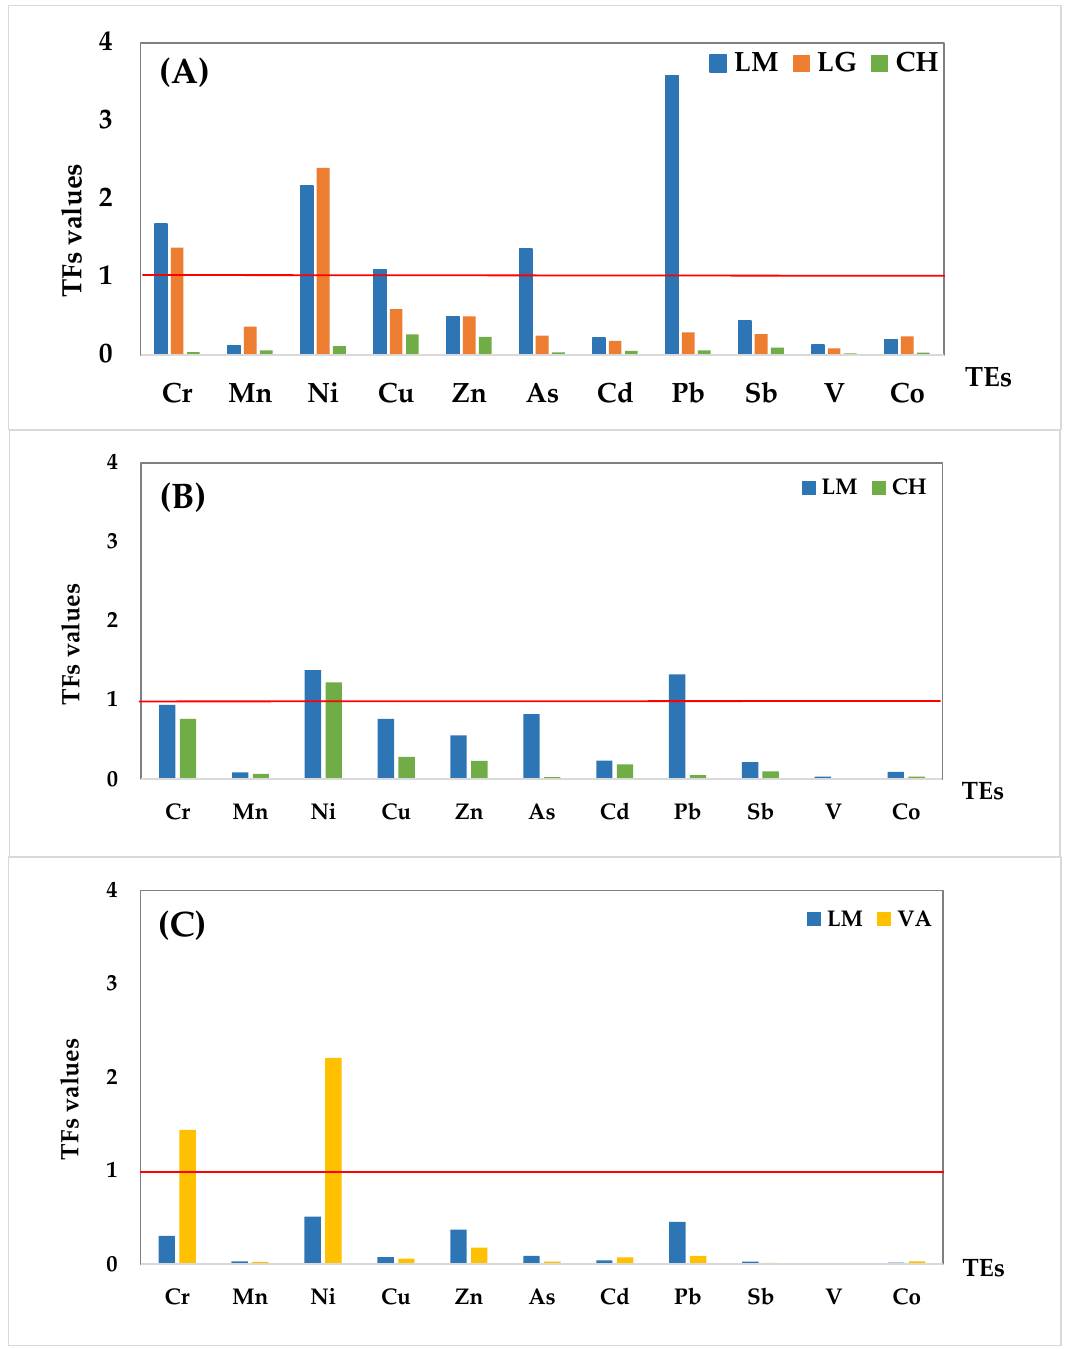
Figure 3. TF values for the 11 trace elements (TEs) at each sampling location according to the plant species: ( A ) O. picensis , ( B ) S. velutina , and ( C ) A. subfusiformis . The red line indicates TF = 1, the low limit for element enrichment.